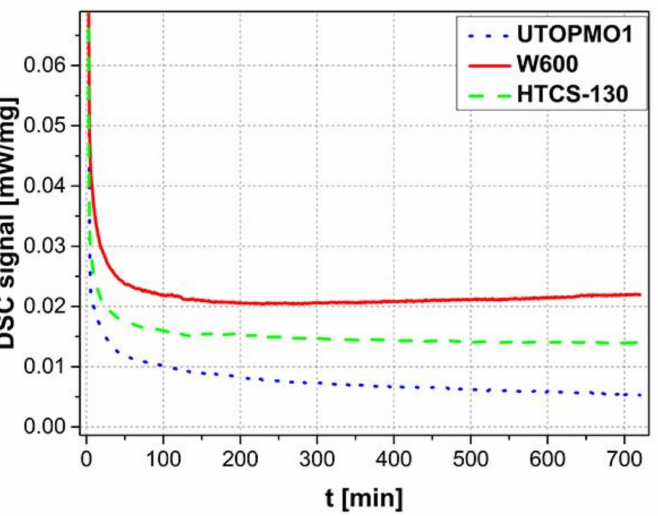
Figure 1. DSC curves of the dissolution of UTOPMO1, W600, and HTCS-130 tool steels in Al99.7 aluminum alloy at 700 ◦